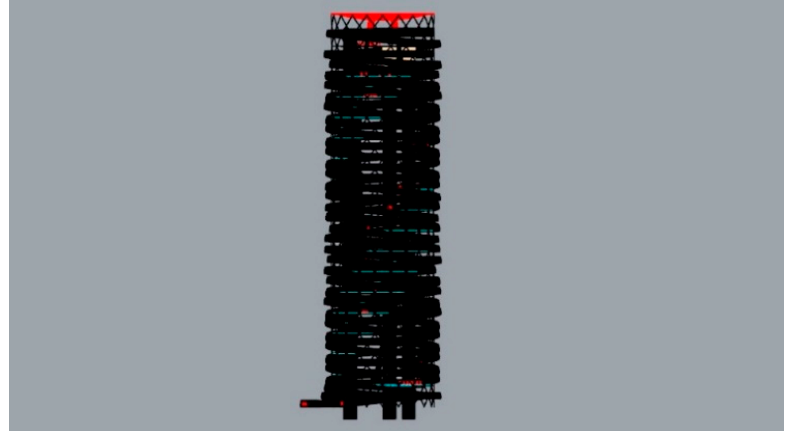
Figure 9. Testa and Weiser, Carbon Tower. Rhino model of a portion of the 1:125-scale three-dimensional (3D) print with geometry adjusted in preparation of steriolithography, 2005. Elevation view. Screen capture for publication. Part of AP174.S1.2001.D1.006, 889.794KB, last modified 21 June 2005. Gift of and © Testa and Weiser.